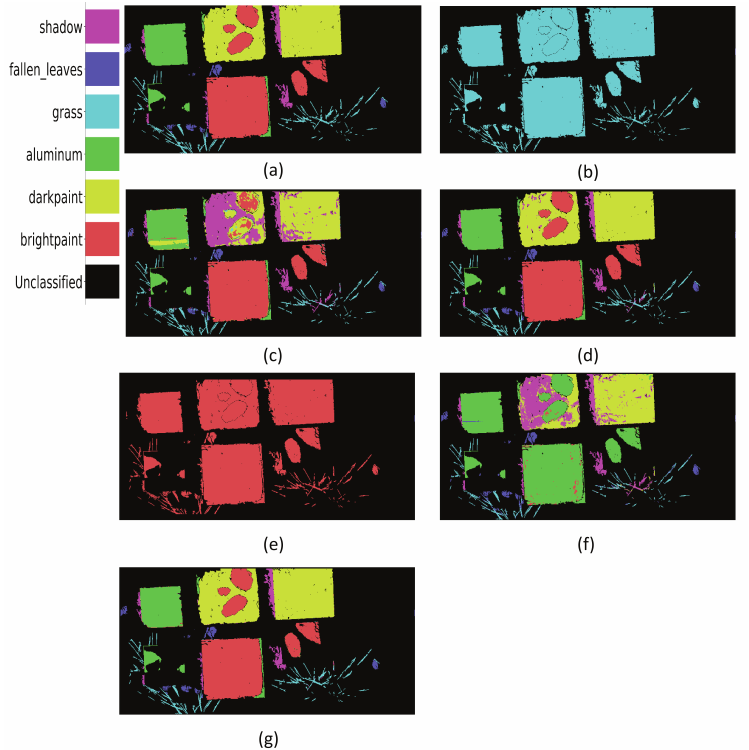
Figure 16. Classification results of YU Paint and Comparison of 3D-CNNs and the proposed ODPA- CNN: ( a ) ground truth, ( b ) Luo model, ( c ) Li model, ( d ) Hamida model, ( e ) Chen model, ( f ) Hu model, ( g ) proposed